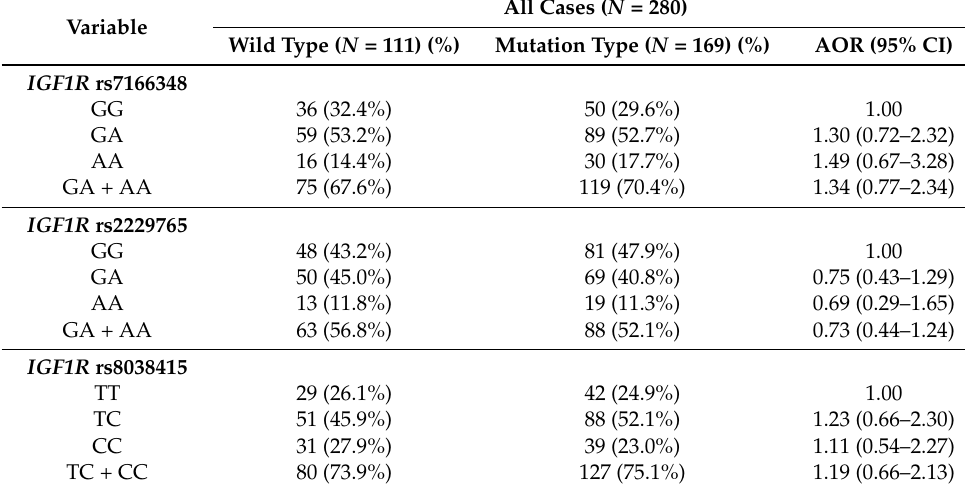
Table 4. Distribution frequency of IGF1R genotypes, the 111 EGFR wild type, and the 169 EGFR mutation type in lung adenocarcinoma